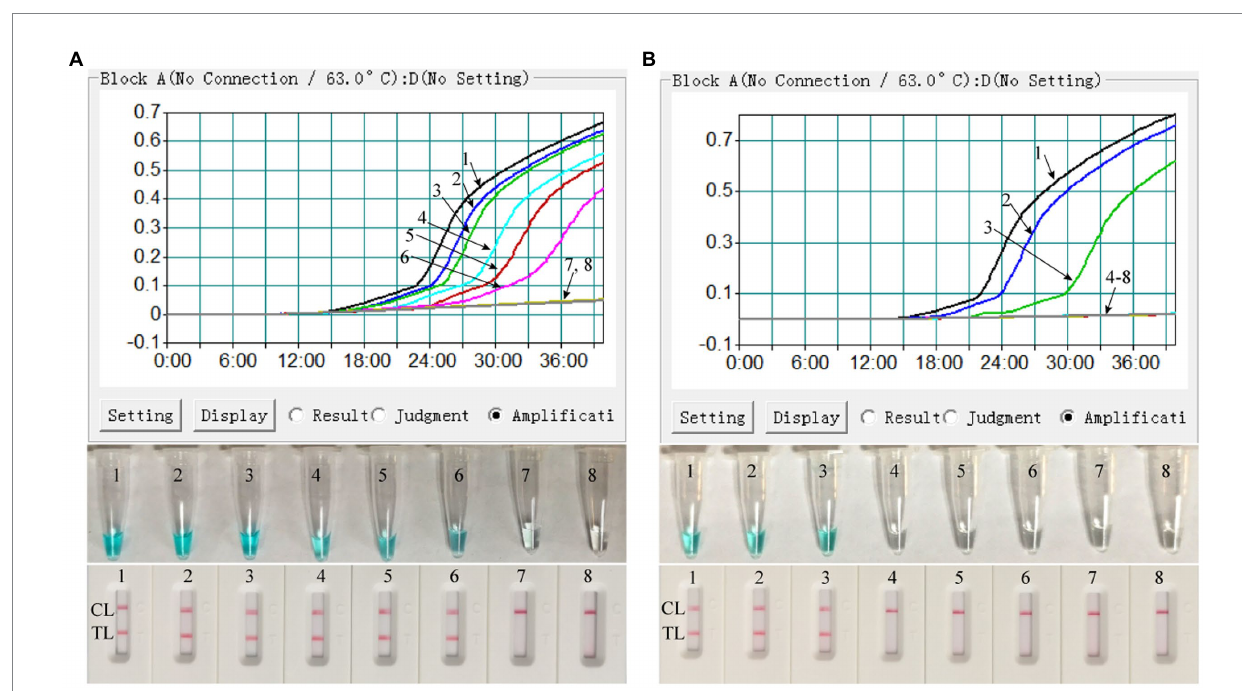
FIGURE 4 Sensitivity confirmation of MPX–LAMP-LFB assay. The sensitivity of the MPX–LAMP-LFB assay was assessed by using the serially diluted ATI-plasmid (A) and the constructed pseudotyped virus (B) . Three monitoring formats, including turbidity (up row), visual detection reagent (middle row), and LFB (bottom row), were applied to detect LAMP products. Templates 1–8 in A were the ATI-plasmid with concentrations of 5 × 10 5 , 5 × 10 4 , 5 × 10 3 , 5 × 10 2 , 5 × 10 1 , 5 × 10 0 , and 5 × 10 − 1 copies permicroliter and the uncontaminated blood sample; Templates 1–8 in B were the constructed pseudotyped virus with concentrations of 1.25 × 10 3 , 1.25 × 10 2 , 1.25 × 10 1 , 1.25 × 10 0 , 1.25 × 10 − 1 , 1.25 × 10 − 2 , and 1.25 × 10 − 3 copies per microliter and the uncontaminated lesional swab sample. TL, test line; CL, control